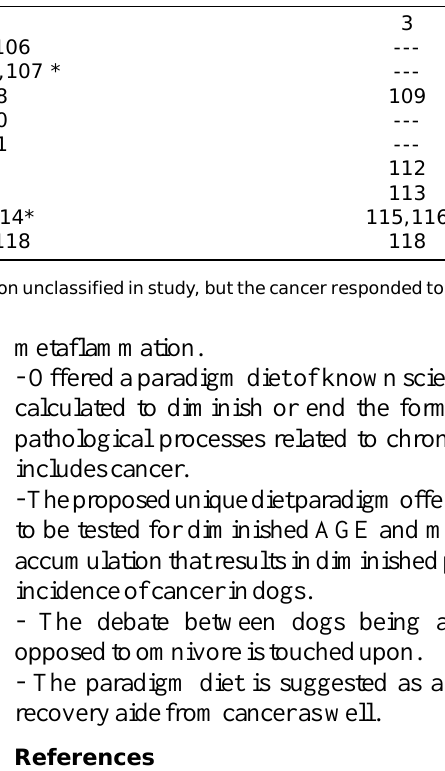
Table-1. Evidence based references for canine cancer, metaflammation, and AGEs Cancer Metaflammation